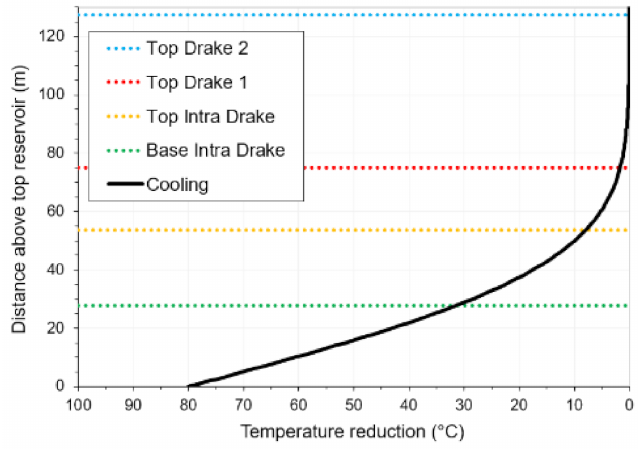
Figure 1. Potential penetration of cooling into Drake caprock after 25 years cooling assuming a constant (cooled) temperature of the underlying Cook